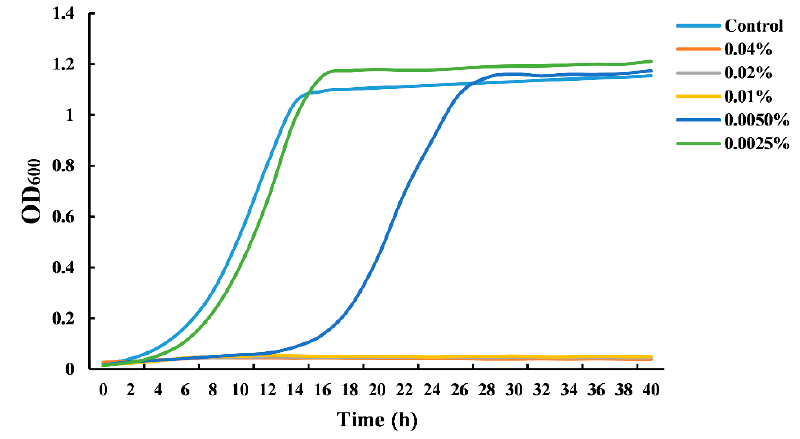
Figure 1. Growth curves of Saccharomyces cerevisiae grown in the presence of cinnamon oil (CIN).